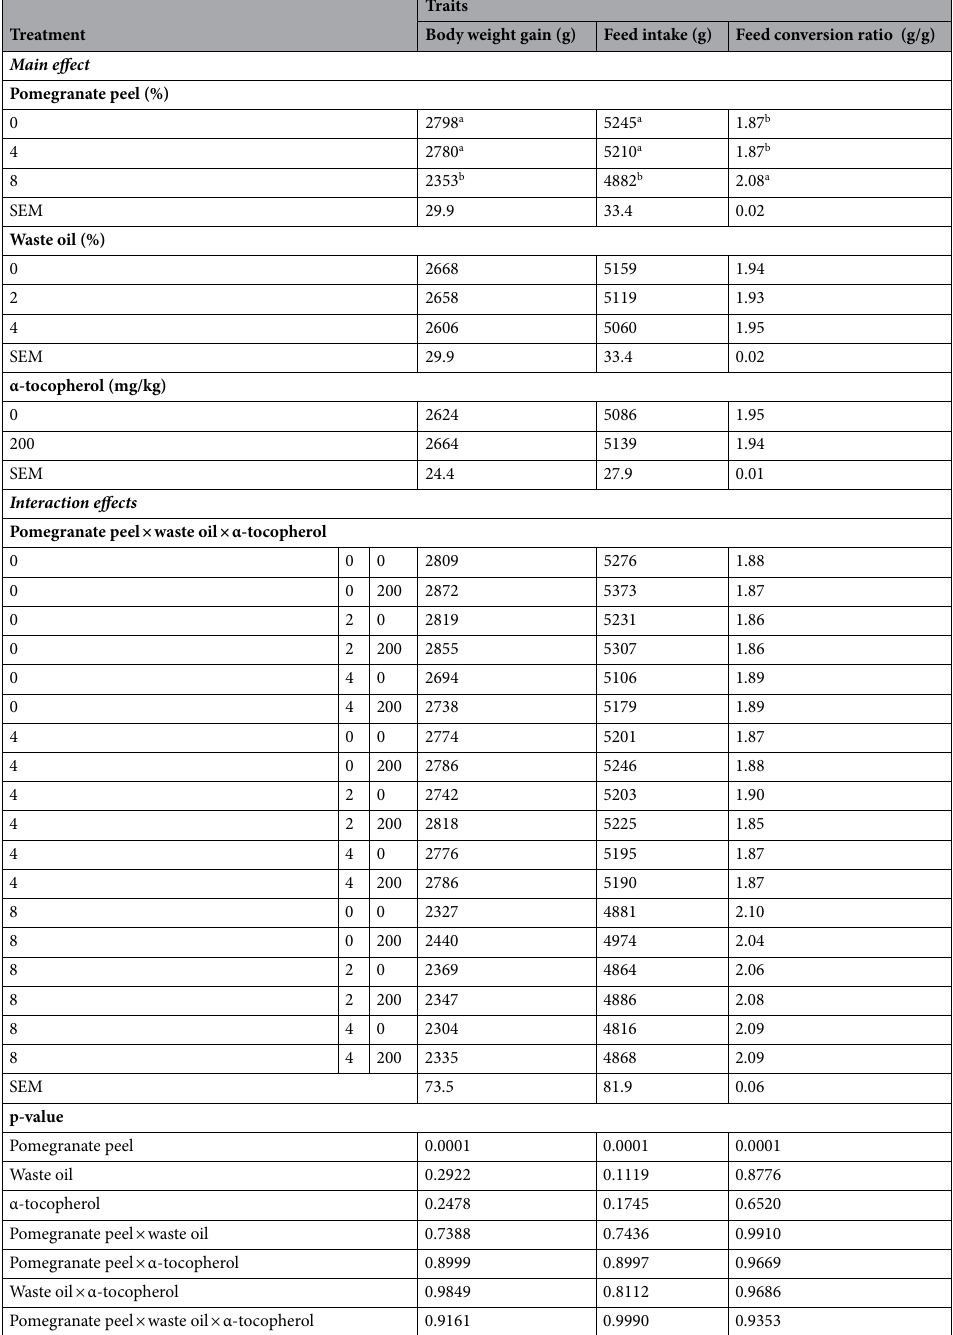
Table 6. The effects of using pomegranate peel, waste oil and α-tocopherol in diets on growth performance in broiler chickens (11–49 days). SEM standard error of mean, P-value probability values. a :b Means in columns with the same superscript do not differ significantly P <